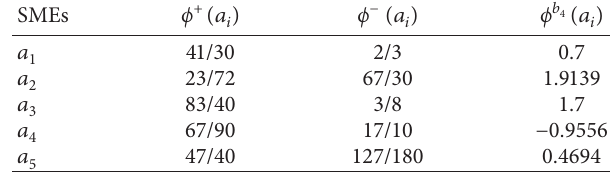
Table 13: The net flow of industry criteria.